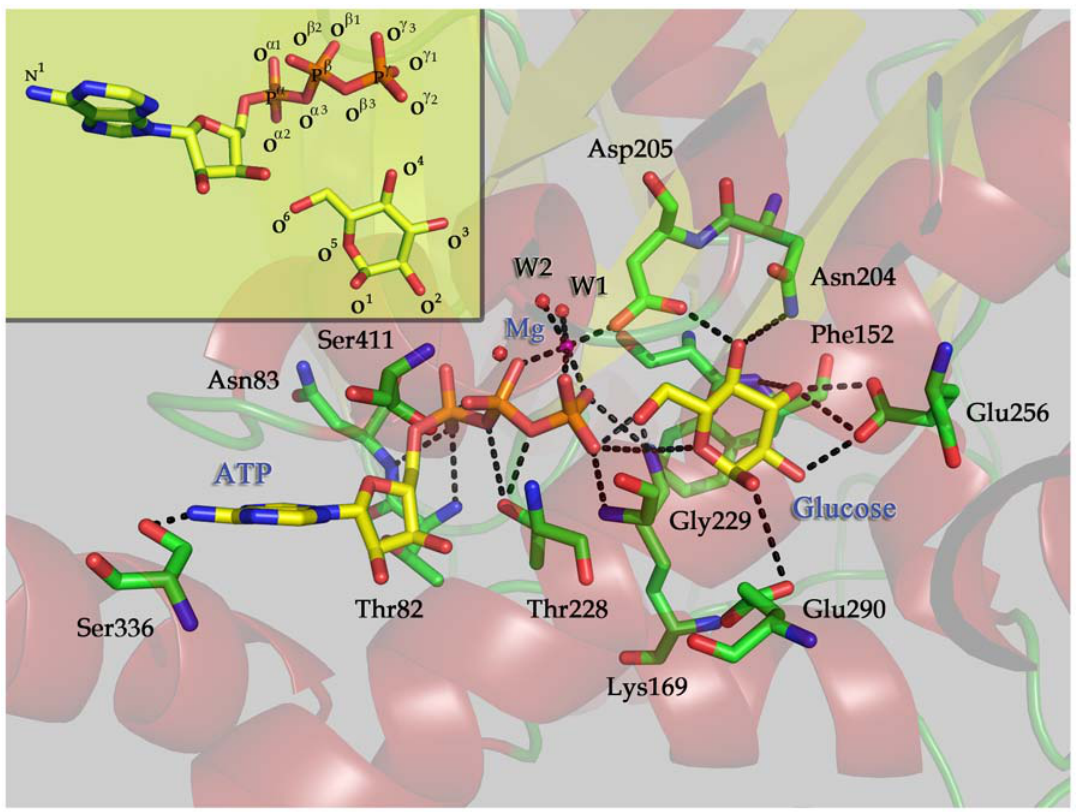
Figure 2. A close view of the configuration of glucose phosphorylation in the environment of GK active site. The structural model was constructed based on the snapshot at 2500 ps isolated from the 10-ns MD trajectory. W1 and W2 represent water molecules. ATP, Mg 2 + , glucose and important residues in GK are displayed in stick and labeled. Black dashed lines represent hydrogen bonds or salt bridges. Atomic numbering of ATP and glucose is displayed in the up-left panel.